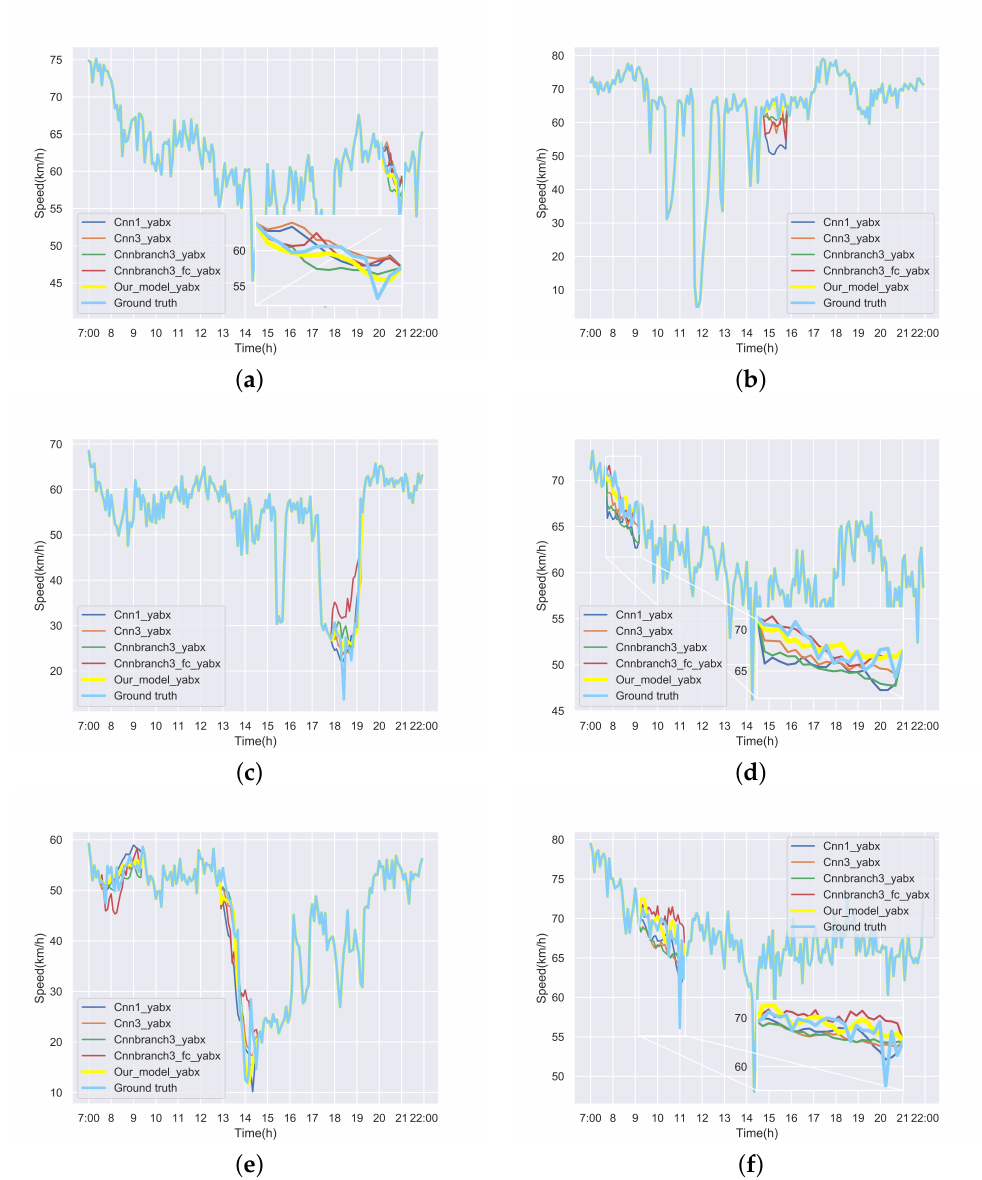
Figure 15. Repaired speed curves and corresponding ground truth of six loop detectors of Yan’an elevated highway. ( a ) The repaired values and the ground truth of the 10th loop detector on the Yan’an elevated highway in the 2nd test day. ( b ) The repaired values and the ground truth of the 35th loop detector on the Yan’an elevated highway in the 3rd test day. ( c ) The repaired values and the ground truth of the 8th loop detector on the Yan’an elevated highway in the 7th test day. ( d ) The repaired values and the ground truth of the 11th loop detector on the Yan’an elevated highway in the 10th test day. ( e ) The repaired values and the ground truth of the 19th loop detector on the Yan’an elevated highway in the 32nd test day. ( f ) The repaired values and the ground truth of the 15th loop detector on the Yan’an elevated highway in the 35th test